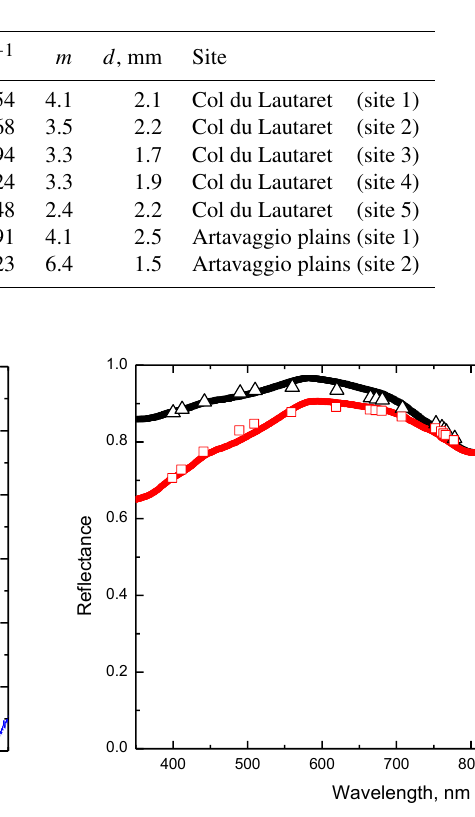
Figure 3. The intercomparison of theory (symbols) with experimen- tal measurements of plane albedo (line) performed in Antarctica (Dome C; 75 ◦ 5 (cid:48) S, 123 ◦ 17 (cid:48) E) for pure snow. The measured plane albedo was obtained on 10 January 2017 at 23:24UTC, for a solar zenith angle of 63 ◦ . The parameters l , f and m have been derived from the measurements at 400, 560 and 1020nm.